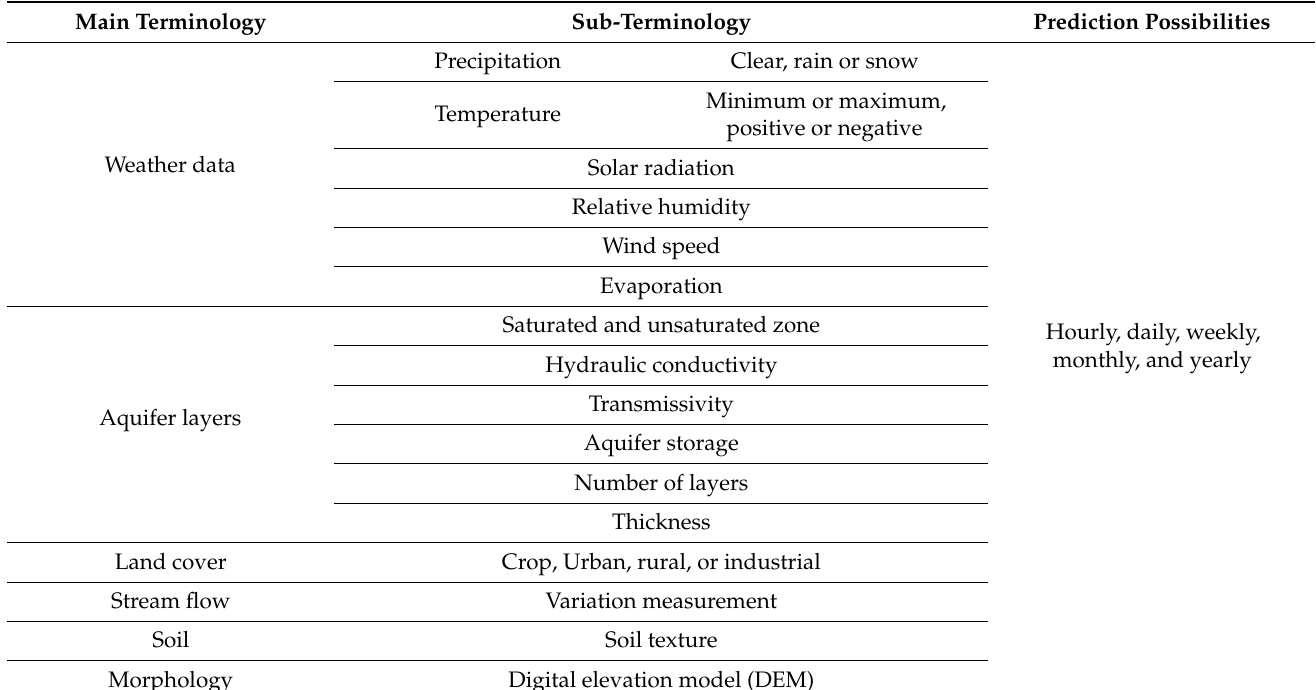
Table 1. Various datasets available for use in modeling parameters and their prediction possibilities [15].